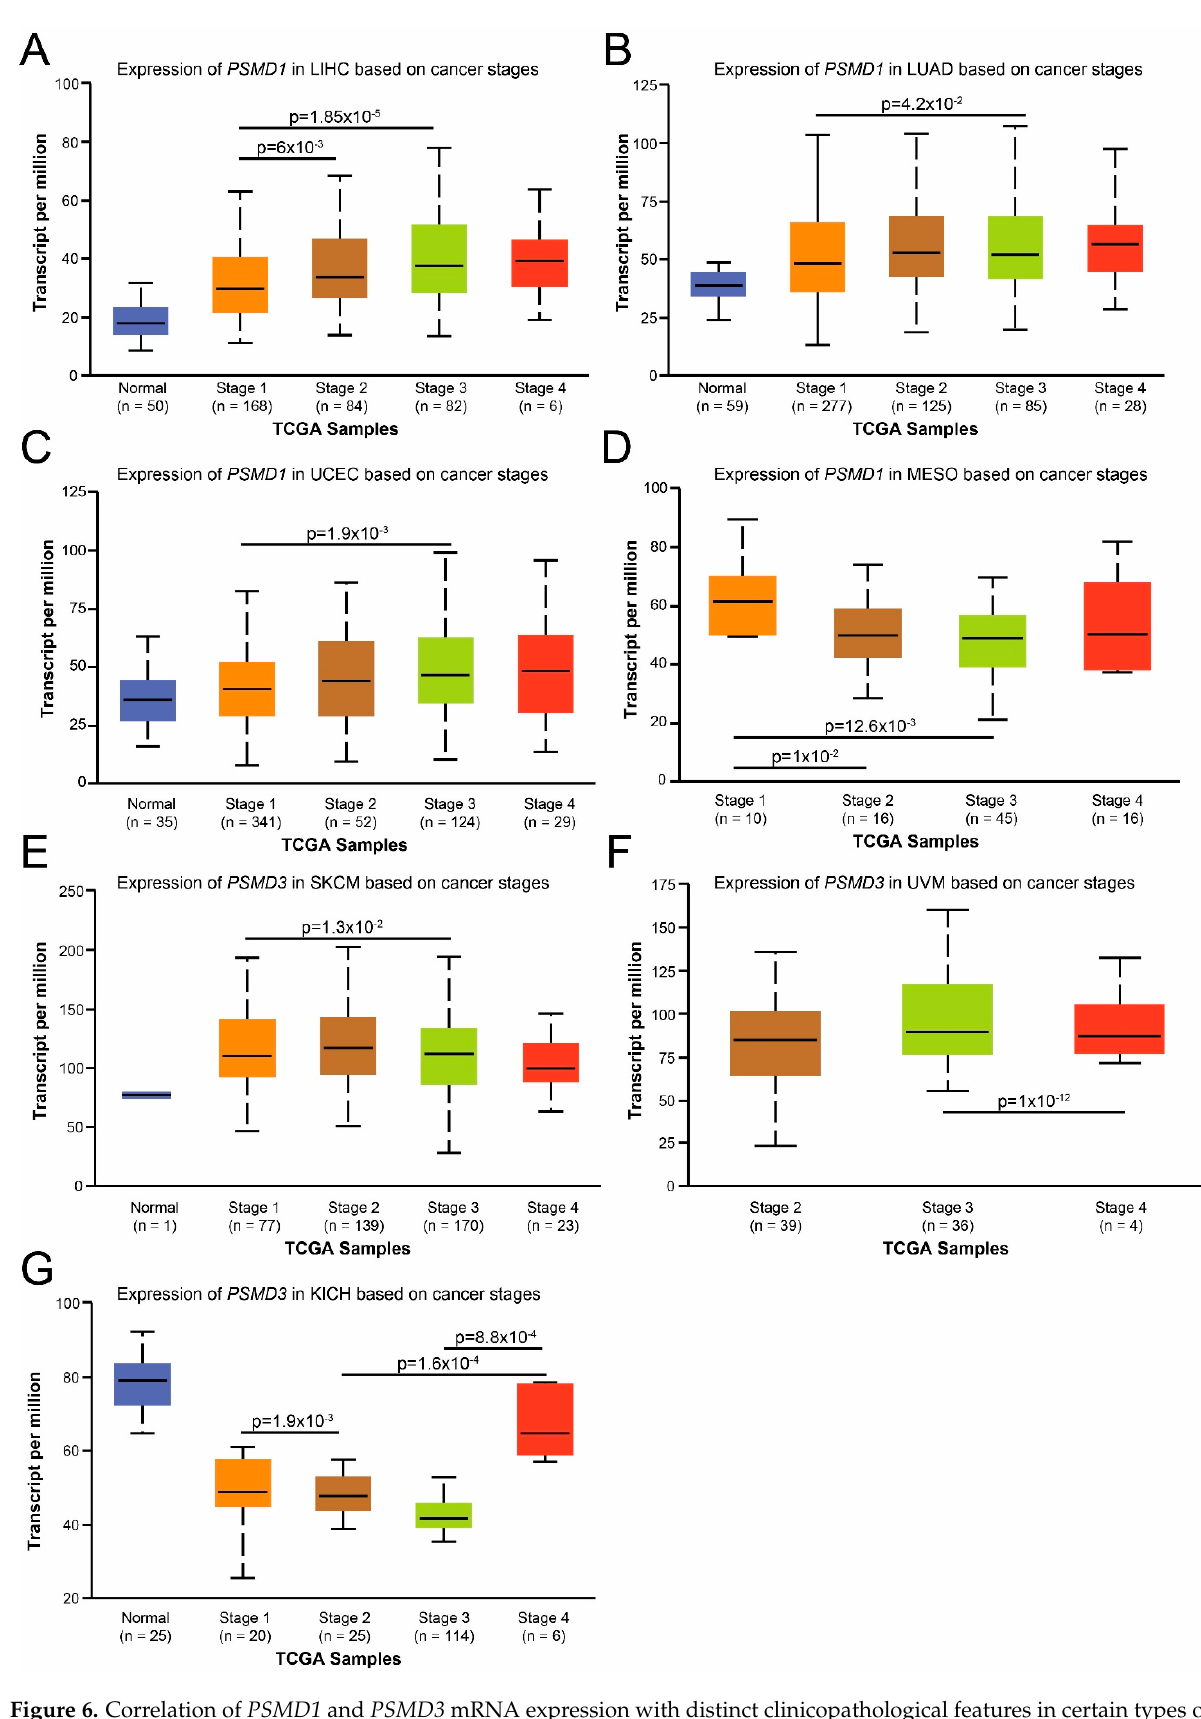
Figure 6. Correlation of PSMD1 and PSMD3 mRNA expression with distinct clinicopathological features in certain types of cancers. We used UALCAN to associate PSMD1 and PSMD3 mRNA expression with clinicopathological characteristics.